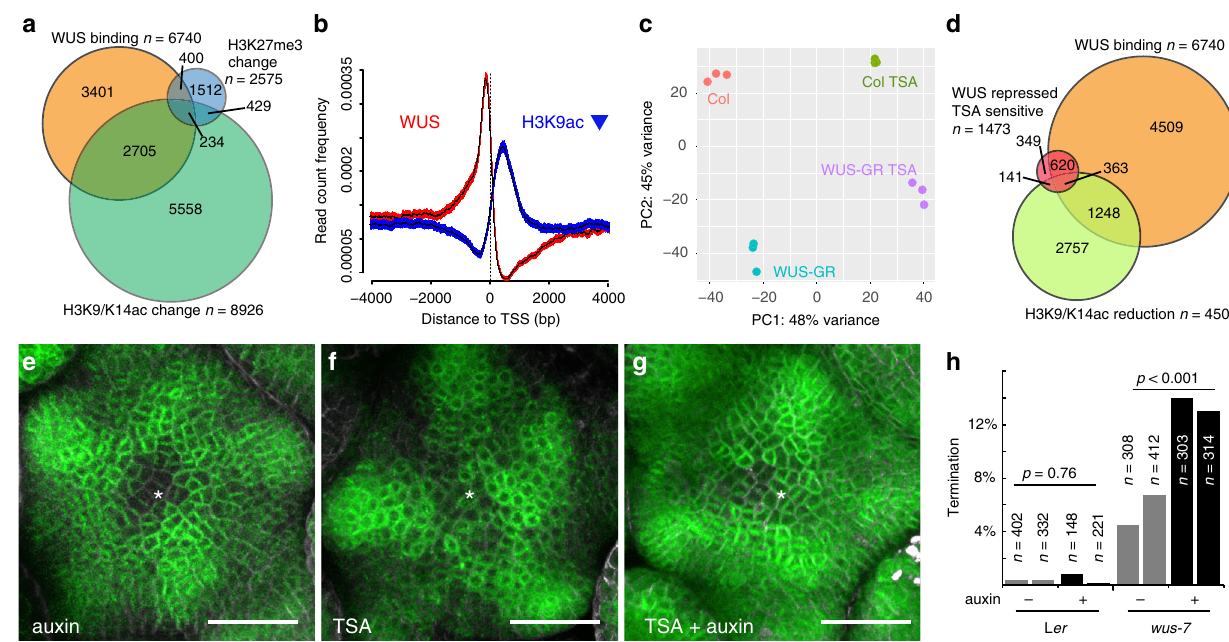
Fig. 6 WUS acts by regulating the histone acetylation status of target loci. a Venn diagram showing the overlap between WUS binding regions (orange), and loci with signi fi cant changes in H3K9K14ac (green) or H3K27me3 (blue) status. b Spatial correlation between WUS chromatin binding events (red) and regions with reduced histone acetylation (blue) 0.95 con fi dence intervals are shown. c PCA showing the global transcriptional response to WUS-GR activation in the presence or absence of TSA. TSA treatment suppressed almost 50% of gene expression variance caused by activation of WUS-GR. d Venn diagram showing the overlap between WUS binding regions (orange), and loci with signi fi cant reduction in H3K9K14ac (light green) and genes whose expression was reduced by WUS in a TSA sensitive manner (red). e – g Representative images of pDR5v2:ER-eYFP-HDEL activity in response to HDAC inhibition. e Auxin treated SAM; f TSA treated SAM; g TSA and auxin treated SAM. Asterisk denote center of the SAM. h Quanti fi cation of terminated seedlings grown on auxin plates from two independent experiments. On mock 5.8% seedlings ( n = 720) segregating wus-7 terminated;